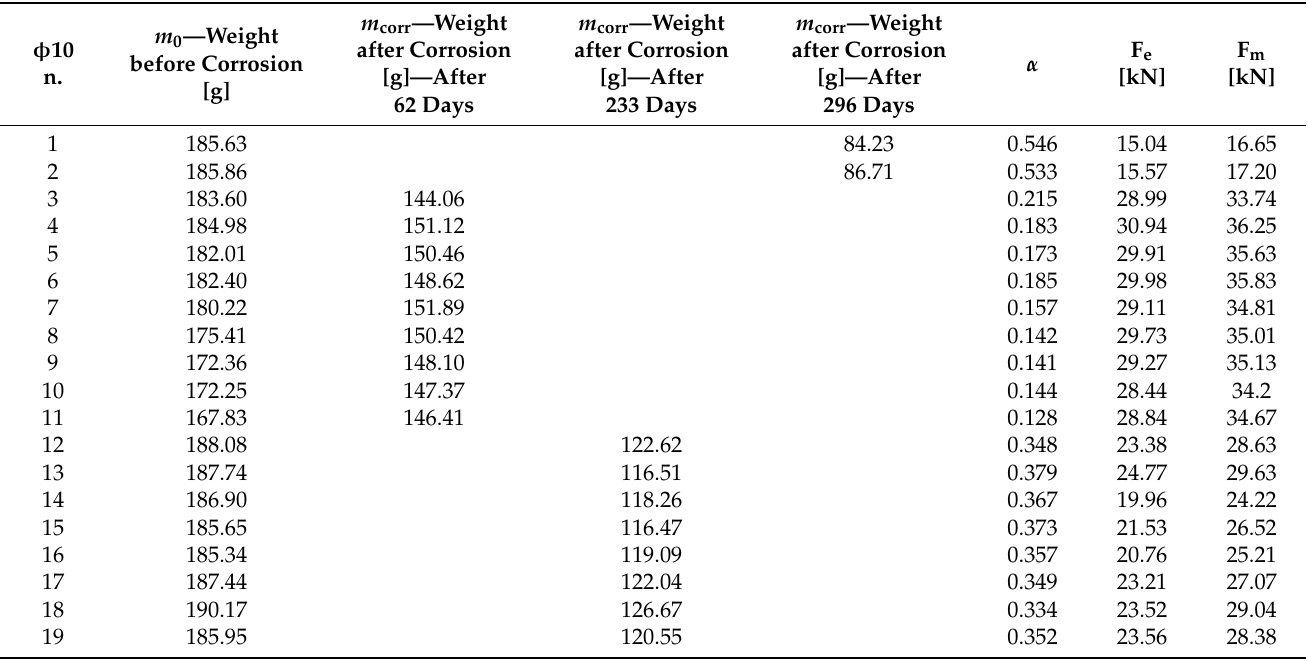
Table 3. The relative weight loss α , the force at yield strength F e and the force at tensile strength F m of the hot rolled with thermal refinement corroded reinforcement φ